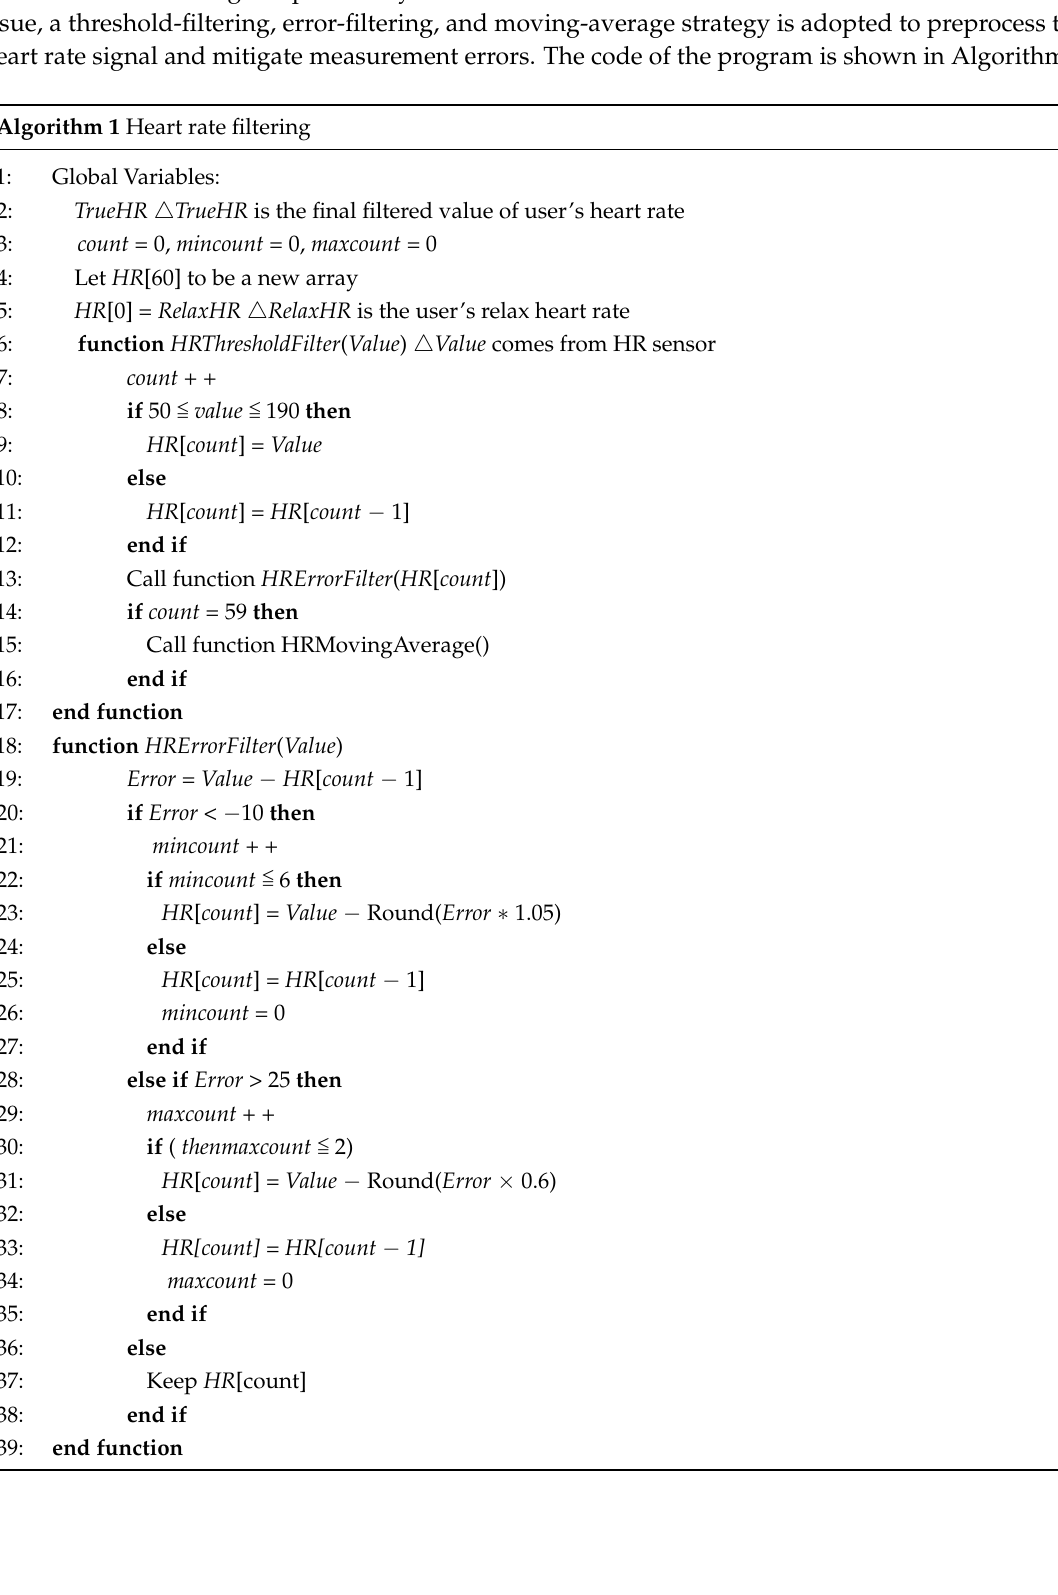
Algorithm 1 Heart rate filtering 1: Global